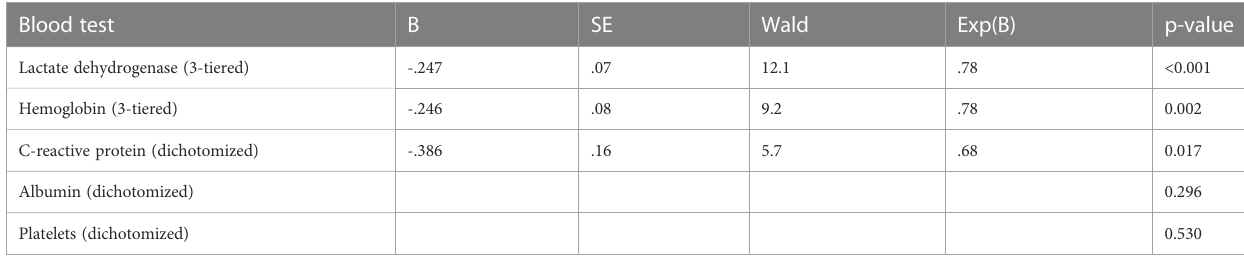
TABLE 2 Multivariate forward stepwise Cox regression